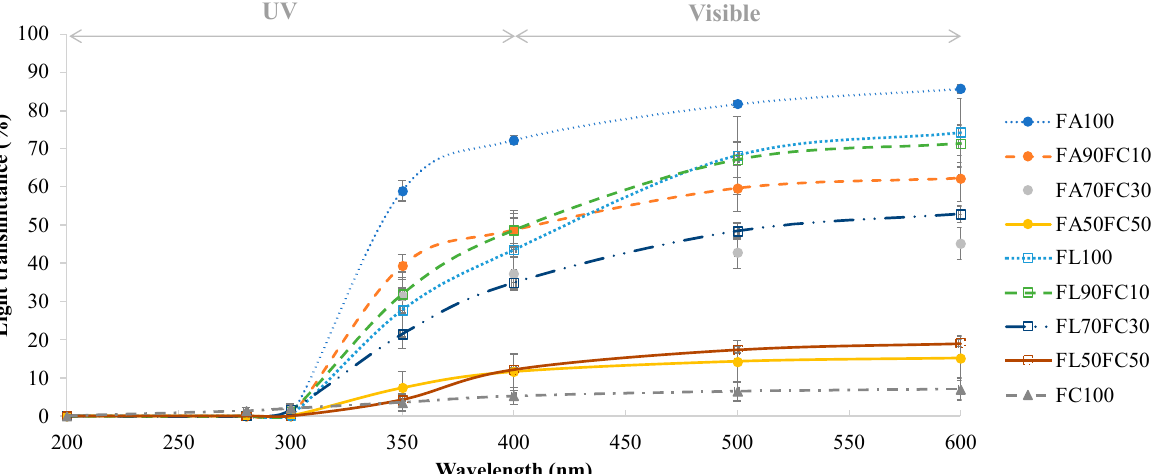
Figure 1. Light transmittance (%) of the films at different wavelengths (200–600 nm). FA refers to acidified plasma protein, FL to lyophilized plasma protein and FC to NFC. The number refers to the percentage of each component added to prepare the film. ANOVA and LSD were performed. Significant differences ( p < 0.05) were found between four different groups (FA100, FL100-FA90FC10-FL90FL10, FA70FC30-FL70FC30, and FC100-FA50FC50-FL50FC50).